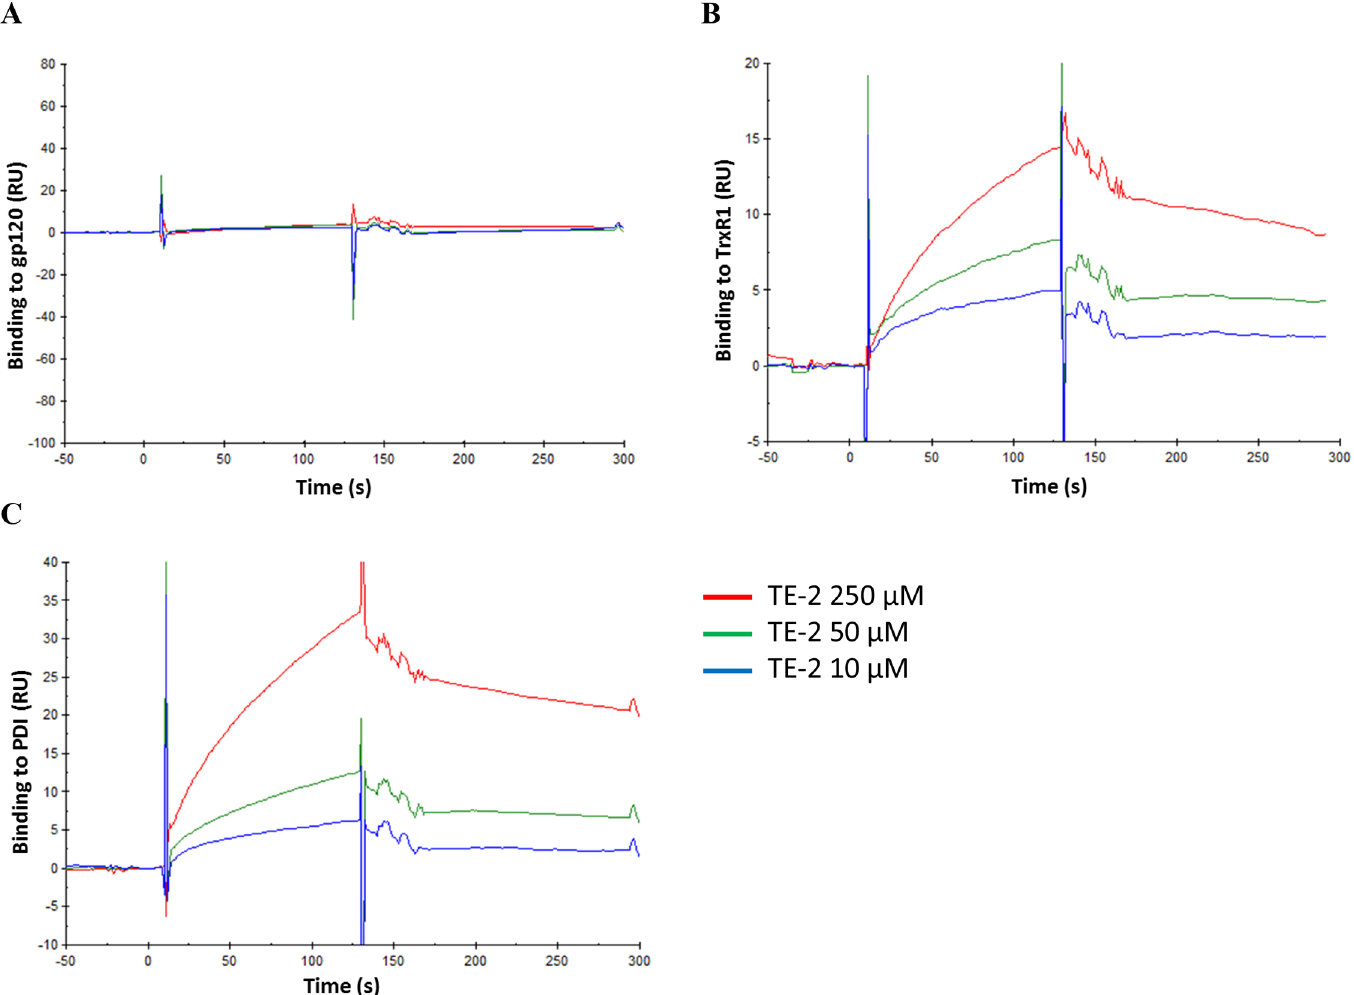
Fig 6. Binding of TE-2 to HIV-1 gp120, TrxR1 or PDI by SPR. The SPR technique was used to evaluate binding of 3 concentrations of TE-2 to gp120, TrxR1 and PDI, using a high density CM5 chip and a Biacore T200 instrument. The SPR sensorgrams show the binding of TE-2 to the immobilised ligand on the chip, and the subsequent dissociation (after 120 sec) of TE-2. (A) Binding of TE-2 to gp120 (B) Binding of TE-2 to TrxR1. (C) Binding of TE-2 to PDI.